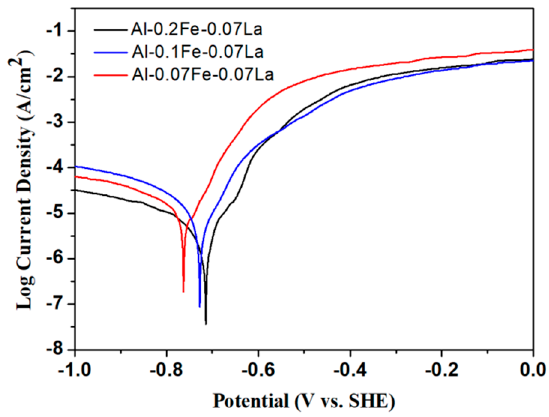
Figure 4. Typical Tafel polarization curves of the Al-xFe-0.07La alloys in 3.5% NaCl solution. Table 2. Tafel polarization parameters of the Al-xFe-0.07La alloys in 3.5% NaCl solution. Alloy E corr (mV vs. SCE) I corr ( µ A / cm 2 ) Al-0.07Fe-0.07La